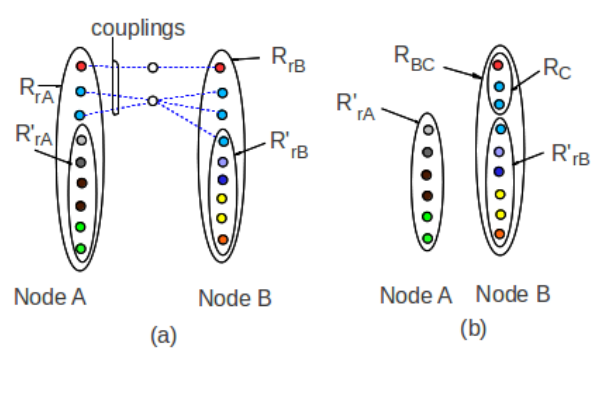
Figure 6. Finding the traitor